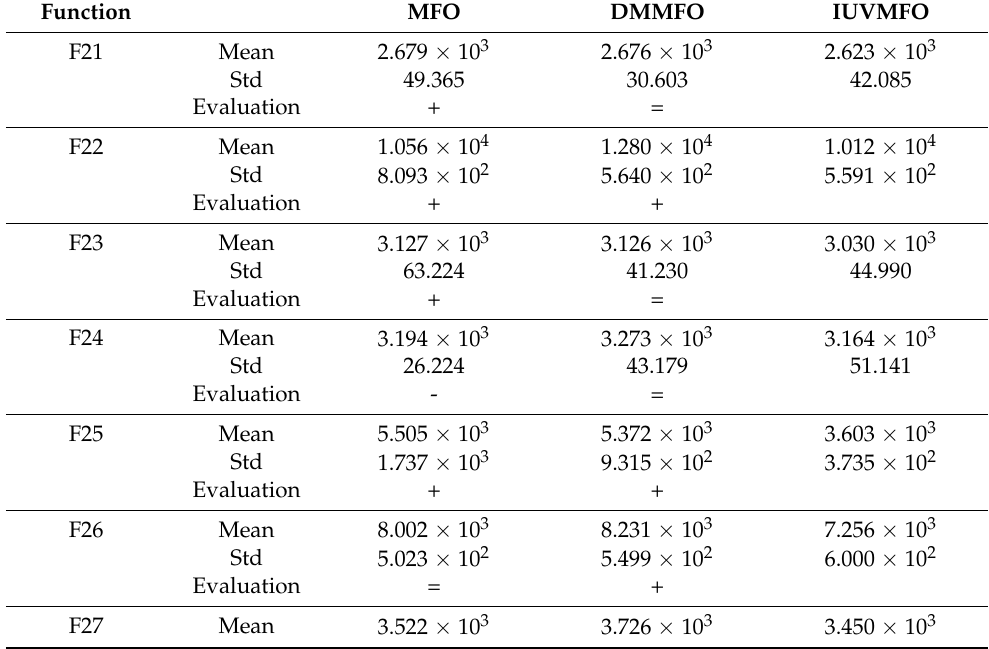
Table 9. Statistics of 50-dimensional Function Test Results.